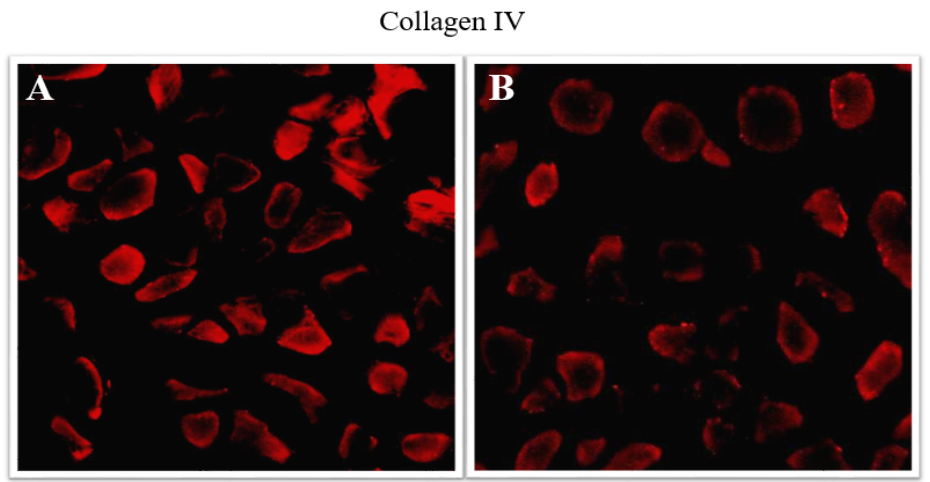
Figure 2. Immunofluorescence reactions anti collagen IV (red fluorescence) in contralateral ( A ) and ipsilateral ( B ) masseter muscle of patients affected by unilateral posterior crossbite. The fluorescence pattern of collagen IV seems to be a higher fluorescence pattern if compared to the ipsilateral one. p -value < 0.05.